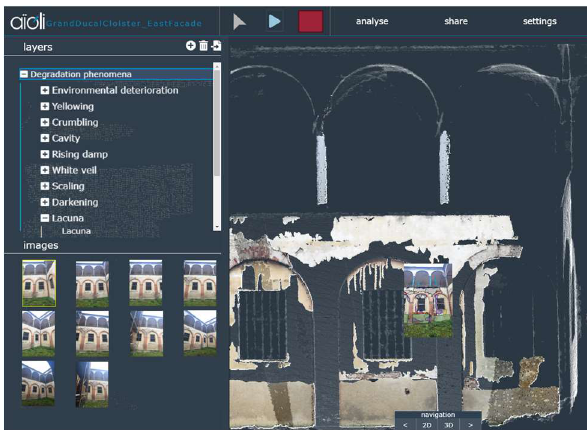
Figure 6. Projection of the annotations in